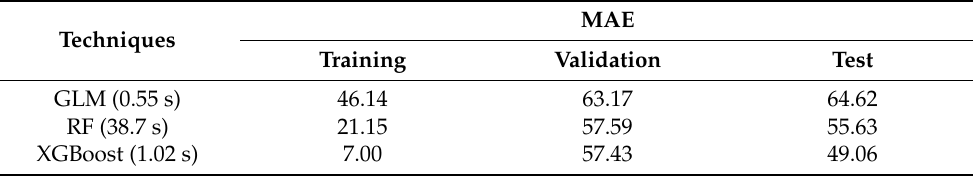
Table 9. MAE for the three techniques for the three partitions of the dataset. Techniques